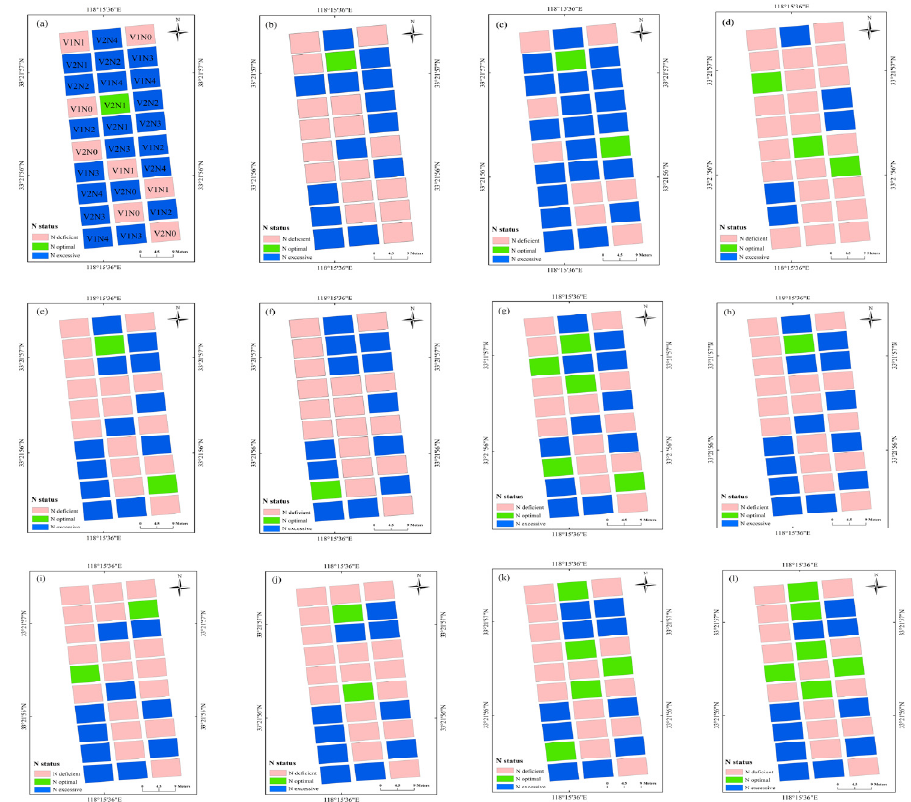
Figure 5. N diagnosis maps (experiment 1) based on the SPAD at the ( a ) jointing, ( b ) booting, ( c ) flowering, and ( d ) filling stage. N diagnosis maps based on the NBI at ( e ) jointing, ( f ) booting, ( g ) flowering, and ( h ) filling stage. N diagnosis maps based on the NDRE at ( i ) jointing, ( j ) booting, ( k ) flowering, and ( l ) filling stage. V1 and V2 in ( a ) represent XM30 and HM20 cultivars. N1, N2, N3, and N4 in ( a ) represent 0, 90 ,180, 270, and 360 kg N ha − 1 treatments, respectively, in Experiment 1.